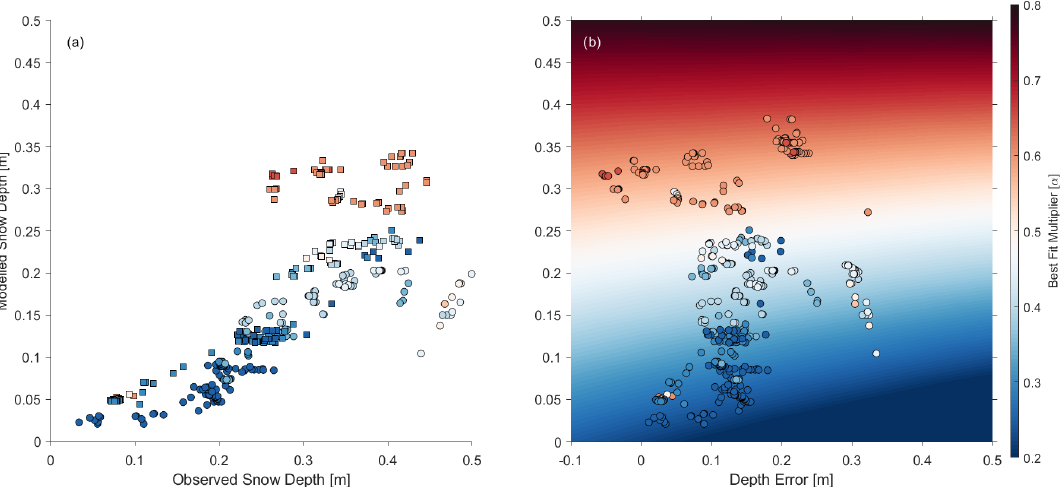
Figure 8. Influence of observed ( x axis; a ) and modelled ( y axis; both) snow depth and snow depth error ( x axis; b ) on the best-fit correction (colour) at each time step for both the 2017–2018 (circles) and 2018–2019 (squares) snow seasons.